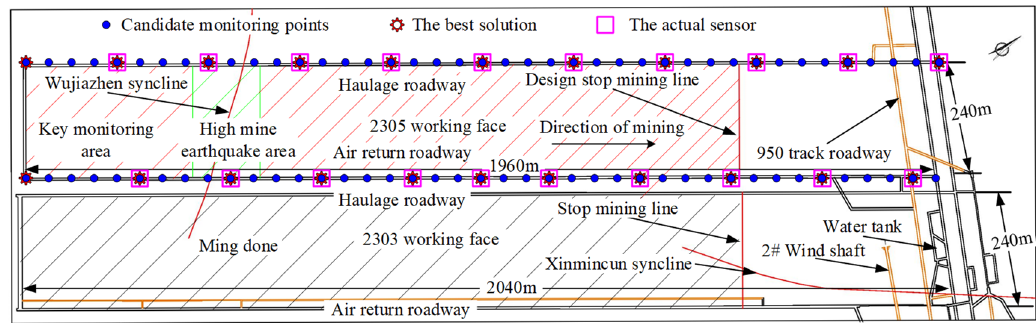
Figure 9. Layout scheme of on-site microseismic network.